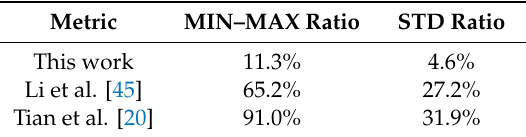
Table 1. The sensor unit sensitivity consistency